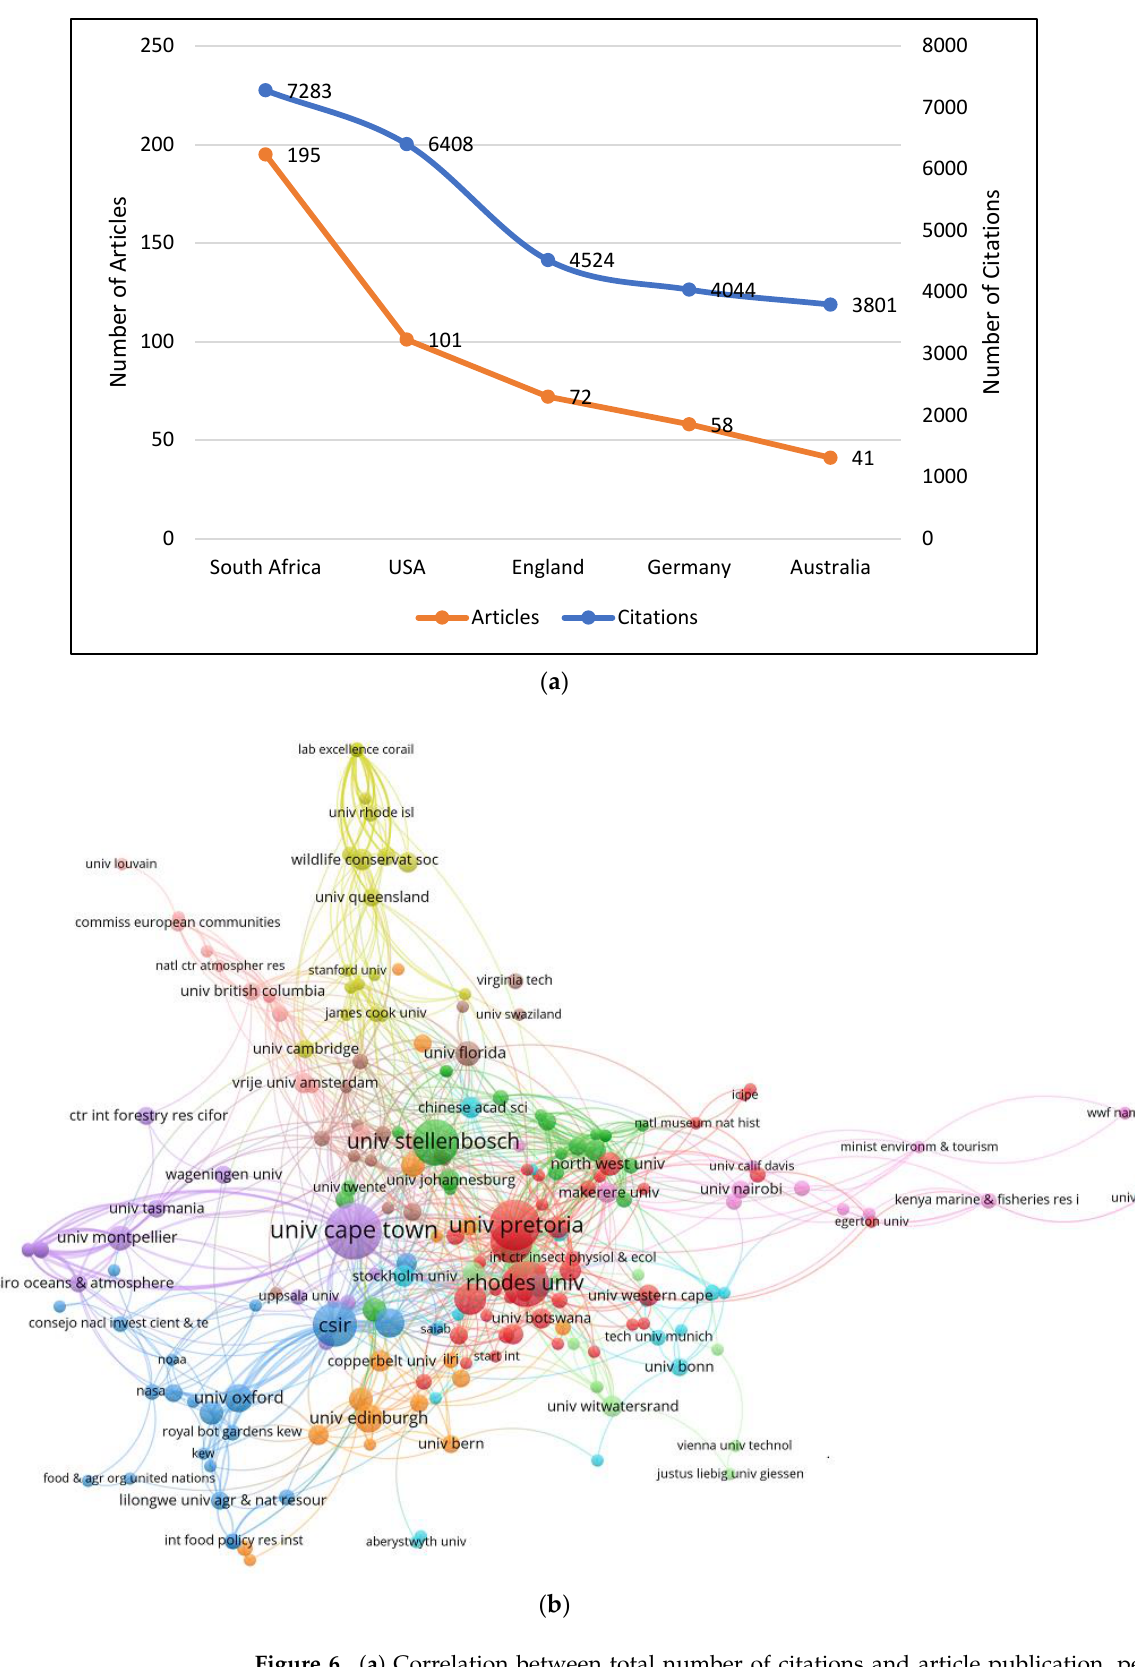
Figure 6. ( a ) Correlation between total number of citations and article publication, per country. ( b ) Most productive institutions publishing on ES research in southern Africa.